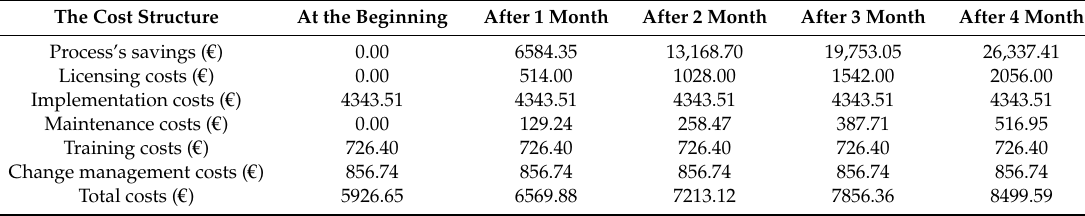
Table 5. Example of the rentability threshold’s results in a calculator